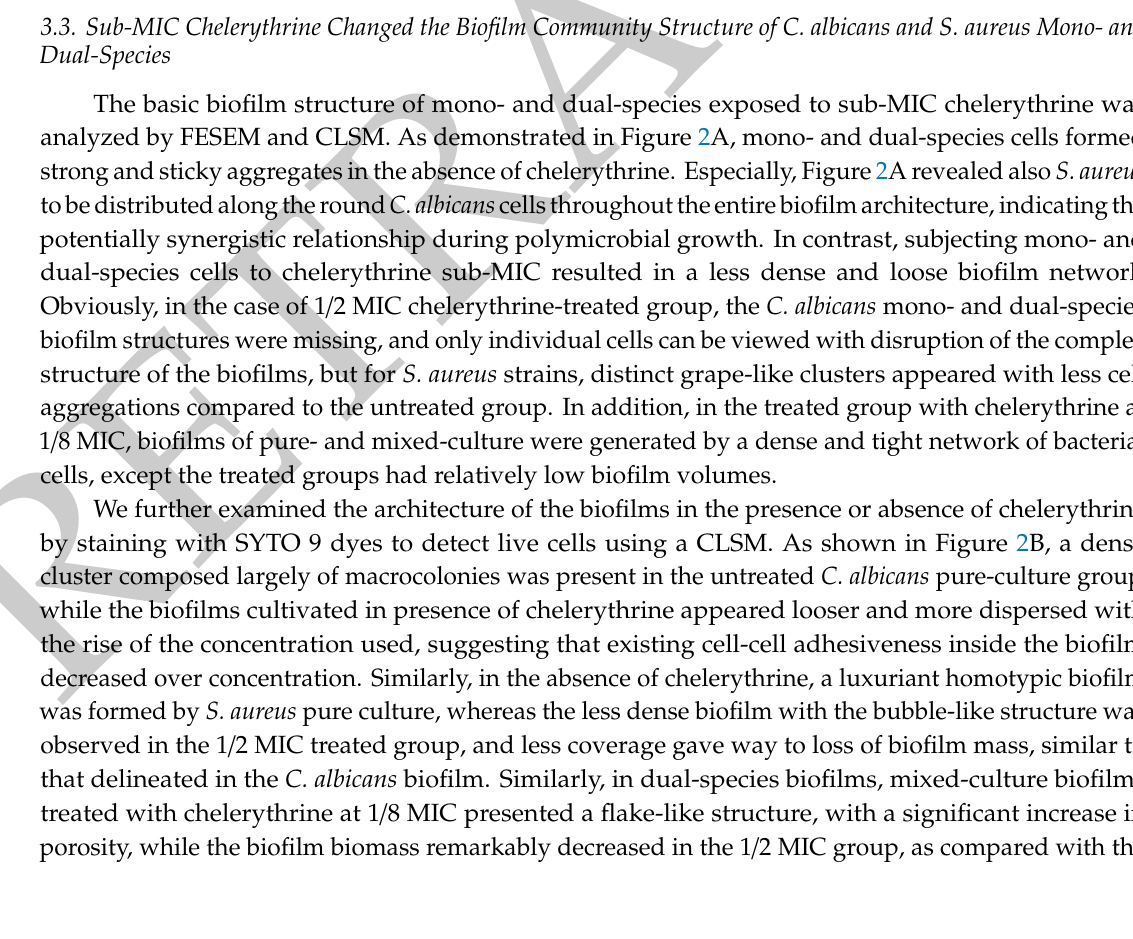
Figure 1. Assessment of different concentrations of chelerythrine on C. albicans (CA) and S. aureus (SA) mono- and dual-species (SA+CA) biofilm biomass by crystal violet staining and cell enumeration by colony count. ( A ) The biofilm biomass was determined using the crystal violet staining assay. Values represent the means of triplicate measurements. ( B ) Biofilm production analysis was performed by cell enumeration (log 10 CFU/coverslips). Bars represent the standard deviation ( n = 3). * p < 0.05; ** p < 0.01; *** p < 0.001; NS, not significant.